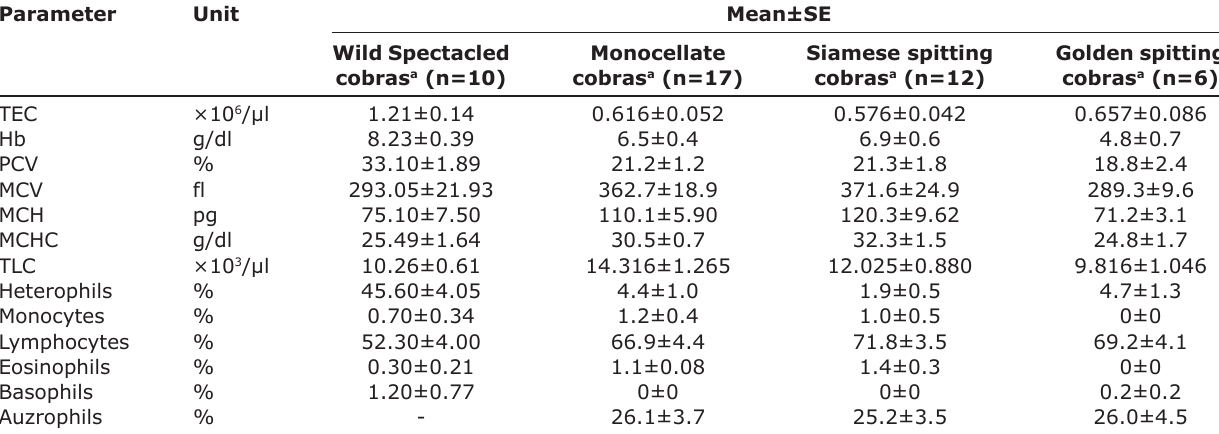
Table-3: Comparison of hematologic values in snakes of genus Naja. Parameter